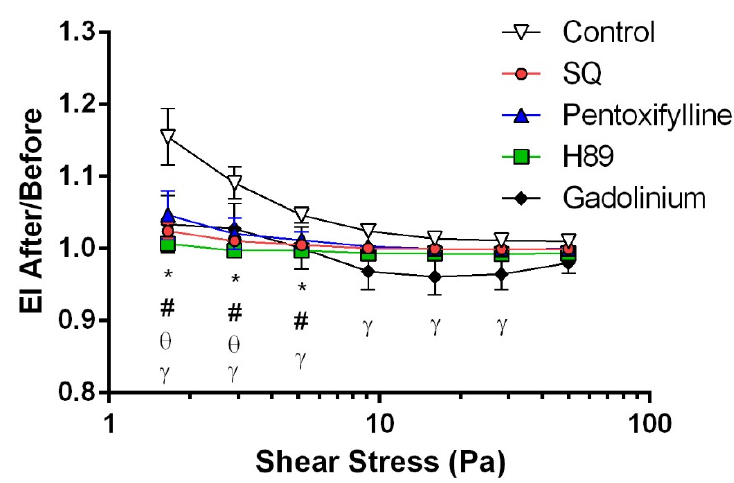
Figure 2. Ratio of the elongation index (EI) values measured after and before the application of 5 Pa shear stress. * p < 0.05 control vs. SQ, θ p < 0.05 control vs. pentoxifylline, # p < 0.05 control vs. H89, and γ p < 0.05 control vs. gadolinium. Data under 0.95 Pa are not plotted. Data are represented as means ± SE, n =